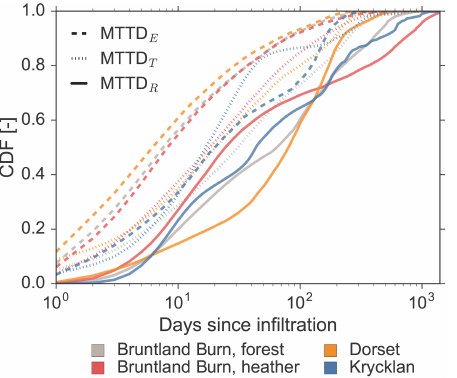
Figure 4. Cumulative density function of the master transit time dis- tributions (MTTD) of the evaporation flux (dashed lines, MTTD E ) , transpiration flux (dotted lines, MTTD T ) , and recharge flux (unbro- ken lines, MTTD R ) for the four study sites (colour code).